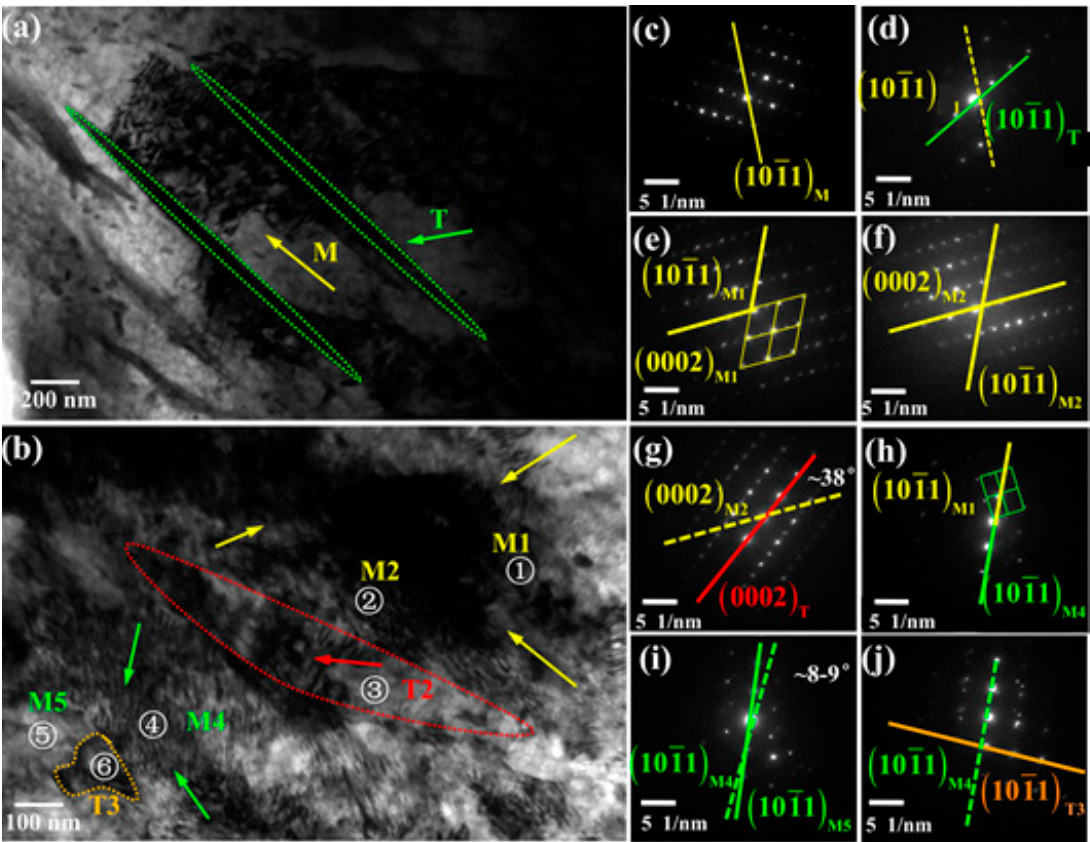
Figure 12. ( a , b ) TEM result of the sheets with cracks and without cracks. The electron beam is nearly parallel to the [–1010] zone axis. The arrow shows the dislocations of different regions. ( c , d ) The diffraction patterns taken from M and T in Figure 12a. ( e – j ) The diffraction patterns taken from the region 1, 2, 3, 4, 5, and 6.